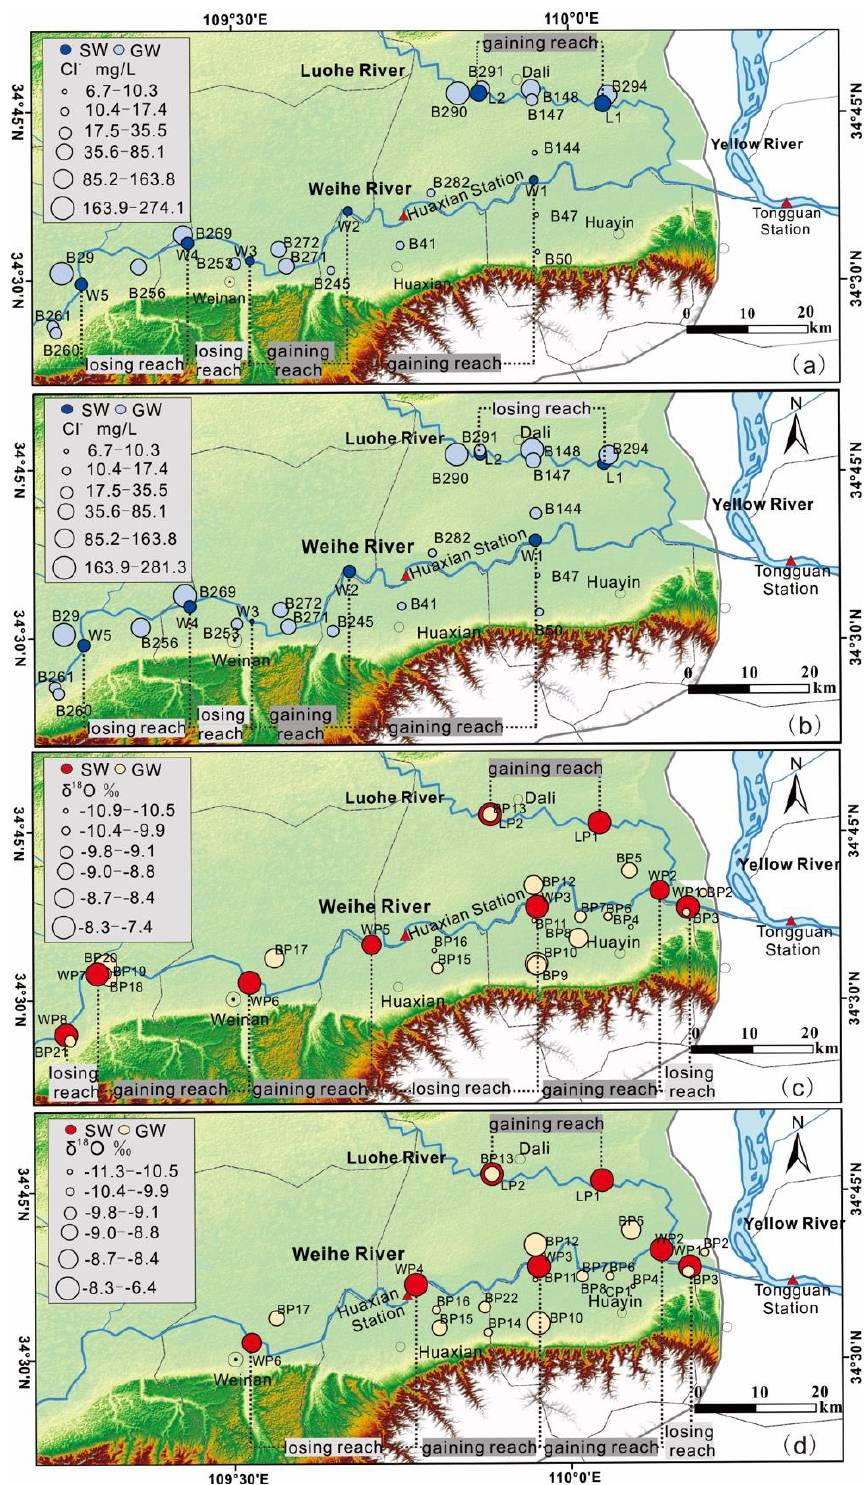
Figure 6. Spatial distribution of the tracers and sketch map of SW – GW interaction patterns along the Weihe and Luohe Rivers, before the dam: ( a ) in May 1959, ( b ) in August 1959; in current status ( c ) in June 2016, ( d ) in September 2016. The segments of the rivers are separated by the surface water sampling sites named with the prefix of WP or LP.